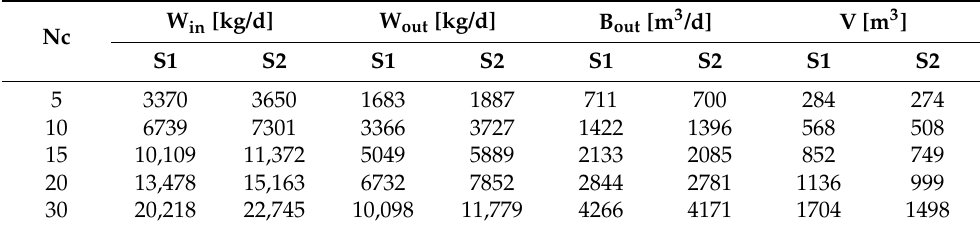
Table 8. Results of W in , W out , B out , and V values for Scenario 1 (S1) and Scenario 2